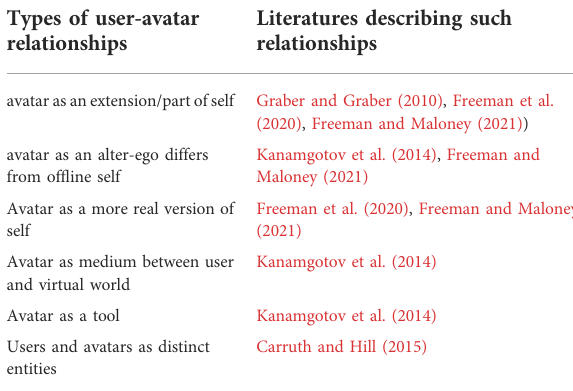
TABLE 4 We summarized typical user-avatar relationships that were observed or de fi ned in literatures. These help us to understand how user perceive their avatar and how to develop protection mechanism for their digital